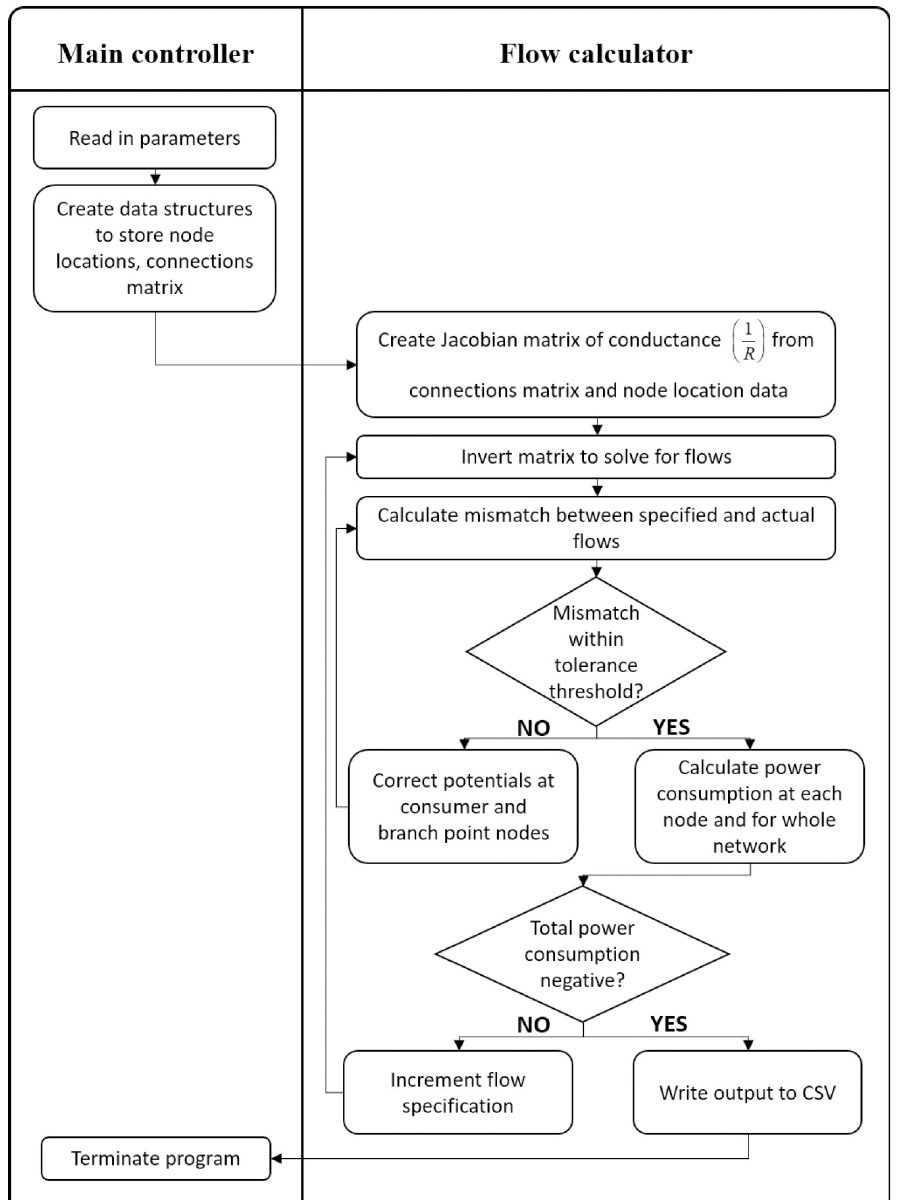
Fig 8. Code flow diagram for flow calculator program. The main controller of the program reads in the parameters and creates the network, and eventually terminates the program when complete, while the main calculations of the program are based on an iterative matrix inversion process in the flow calculator